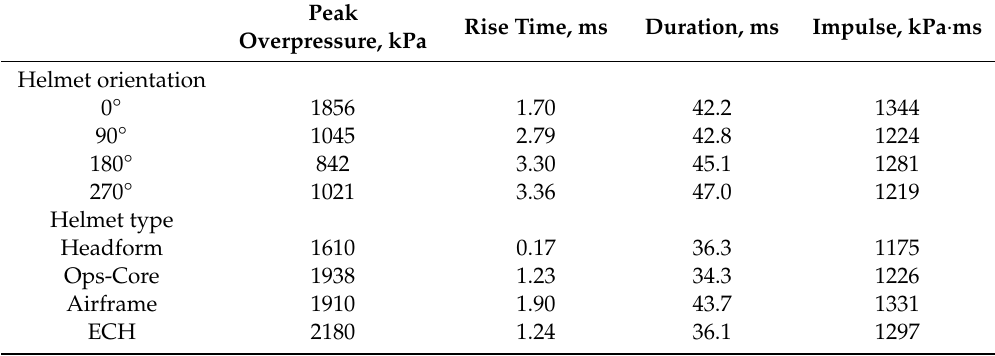
Table 1. The aggregate values (sum of averages) obtained from the quantification of the peak overpressure, rise time, duration, and impulse in the: (1) helmet orientation (ACH), and (2) helmet type (Ops-Core, Airframe, ECH) blast tests. The unprotected headform was used as a reference in the helmet type